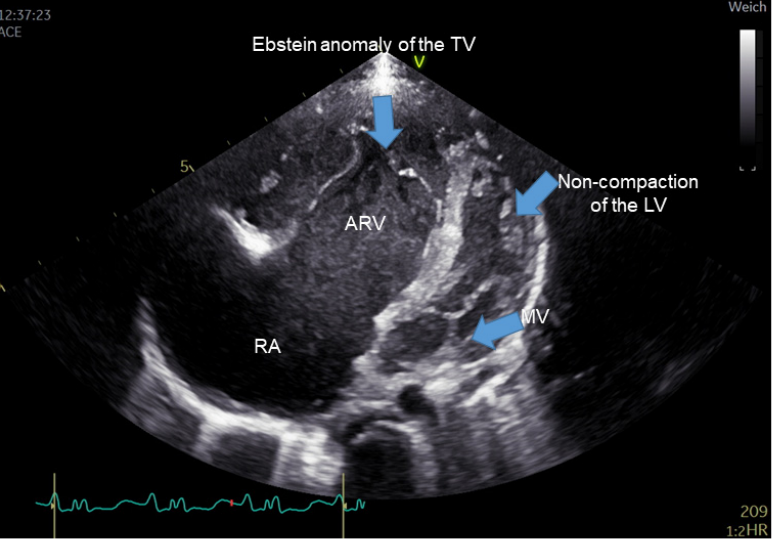
Figure 1. Transthoracic echocardiographic image showing the four-chamber view. The characteristic malformation of severe Ebstein’s anomaly of tricuspid valve in the right heart is clearly seen with an apical displacement of the septal leaflet of the tricuspid valve, leading to marked enlargement of the right atrium and atrialized right ventricle (ARV). The left ventricle shows prominent apical trabeculation suggestive of non-compaction of the left ventricle. ARV, atrialized portion of the right ventricle (ARV); TV, Tricuspid valve; MV, mitral valve; LV, left ventricle; RA: right atrium. The patients could be classified based on the New York Heart Association (NYHA) three patients (18.75%) in class II, and five patients (31.25%) were in class III. Eight patients (50.0%) had compaction cardiomyopathy of the left ventricle and seven patients (43.75%) had associated Supraventricular arrhythmias. The mean systolic blood pressure (SBP) was 120 ± 9.69 mm Hg, the mean diastolic blood pressure (DBP) 67.4 ± 9.32 mm Hg. In seven patients (43.75%) an ASD was detected, two of them had a right-left shunt across the ASD. These two patients had an oxygen saturation of 85% and 93%. The mean LV fractional shortening (LVFS) among patients was 33.9 ± 7.36%, mean LV Tei index was 0.36 ± 0.16, mean ICT 47.69 ± 25.70 ms, mean isovolumic relaxation time (IVRT) 62.46 ± 40.86